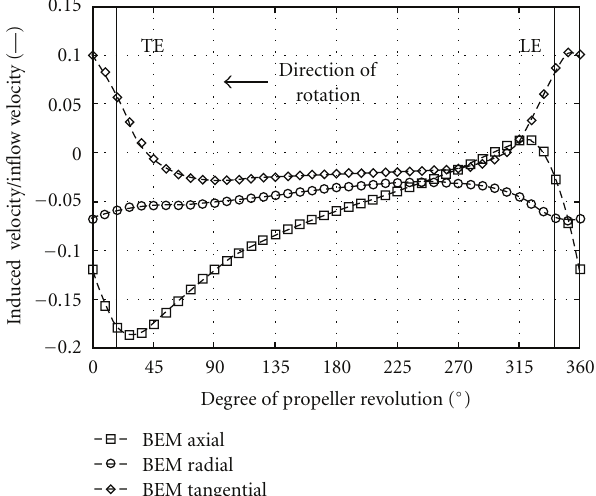
Figure 6: Comparison of the normalised induced axial velocities obtained from the explicit and the implicit coupling approach ( r/R = 0 . 7, J = 0 . 5, dt · n = 3 . 78 ◦ , and dx = 0 . 5 R ).